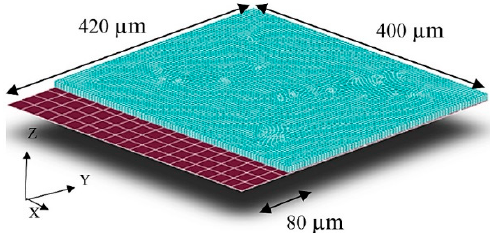
Figure 3. The modified parallel plate actuator. The bottom electrode is expanded along the y ‐ axis so that the fringe effect causes larger electrostatic force in the y direction than in the x